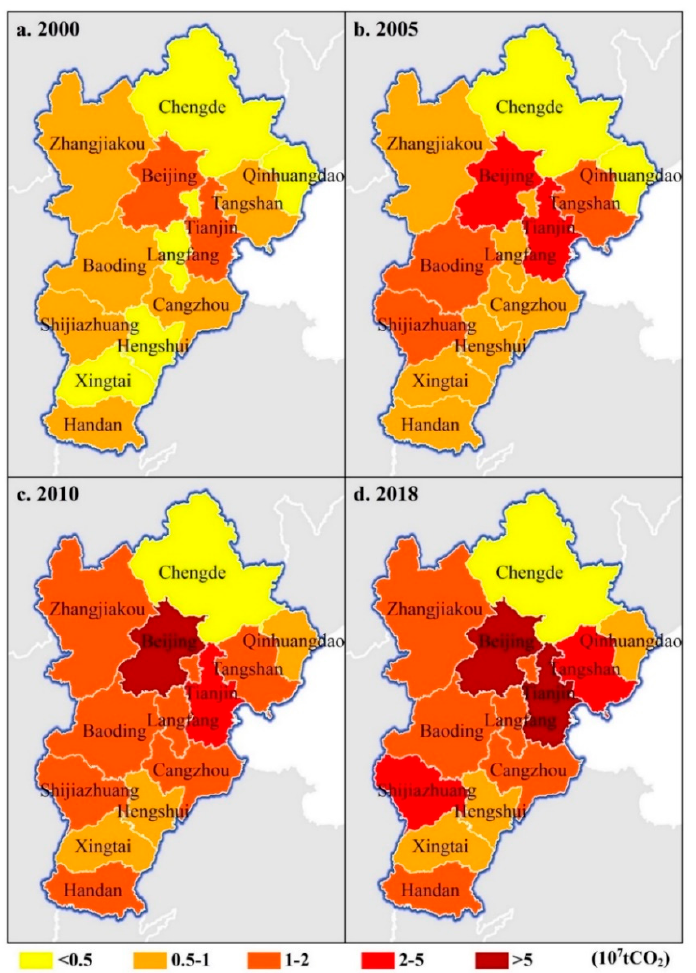
Figure 8. Spatiotemporal evolution of CO 2 emissions in Beijing–Tianjin–Hebei from 2000 to 2018.